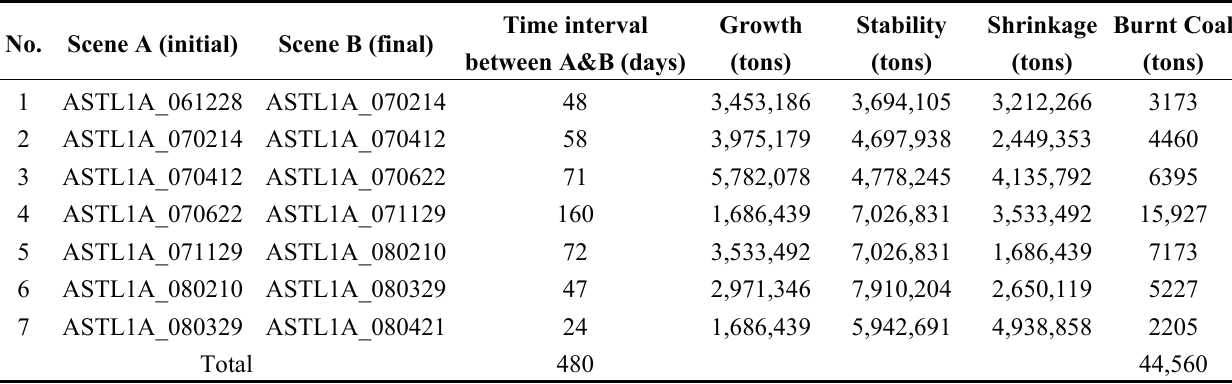
Table 4. Coal fire-influenced equivalent coal quantity and burnt coal for different change detections